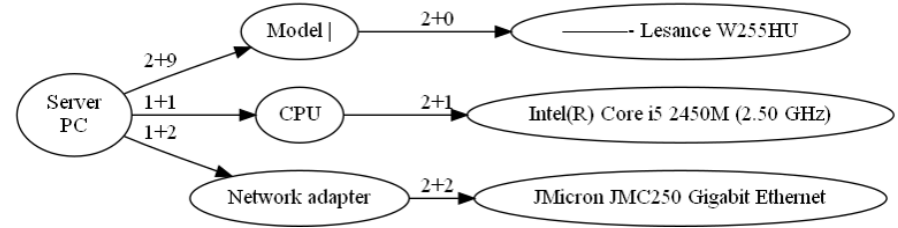
Figure 4. Topology tree for the first row of example